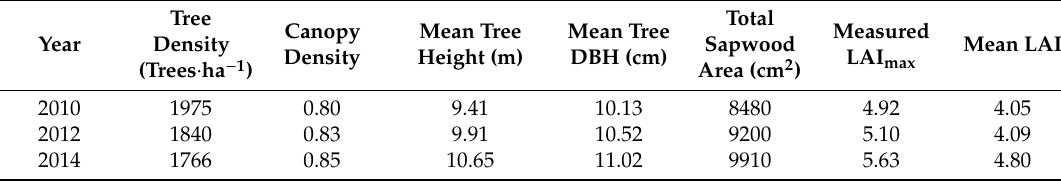
Table 1. Characteristics of the trees in the larch plantation